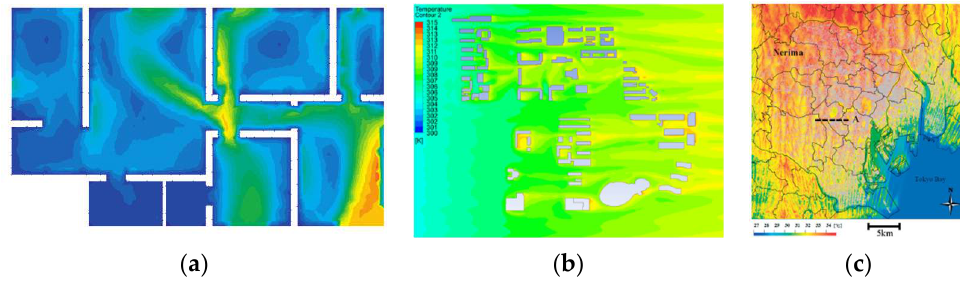
Figure 4. Definition and classification of scale for CFD-based simulations of the USTE: ( a ) Microscale [60]; ( b ) Block scale; ( c ) Macroscale [63].